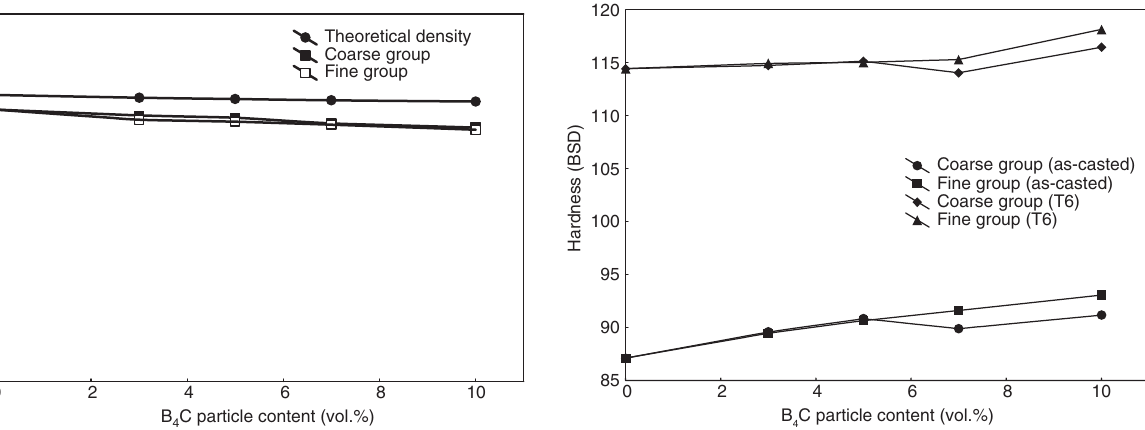
C Figure 4 Hardness values of composites with B 4 and size in the T6 and as-casted